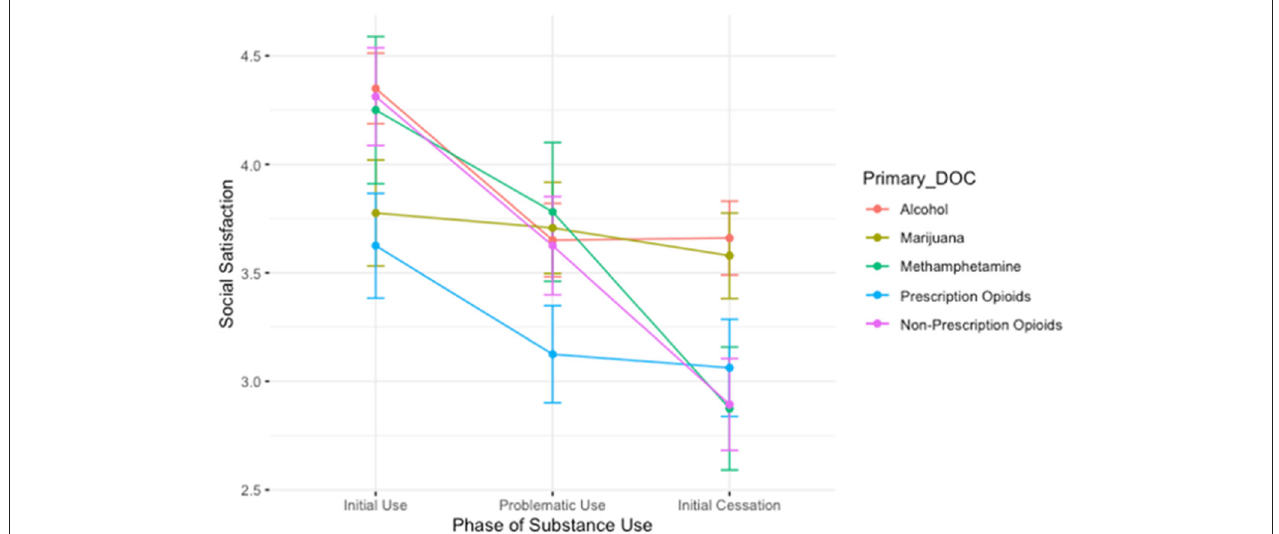
FIGURE 2 | A plot showing the average social satisfaction scores for participants during the initial stages of use, the height of problematic use, and during the initial stages of cessation. Lines are colored by participant primary substance of choice. The groups showing the steepest decrease in social satisfaction between the height of use and period of initial cessation are those who reported using methamphetamine and non-prescription opioids, while those who used prescription opioids reported lower satisfaction than those in other groups during the height of problematic use.